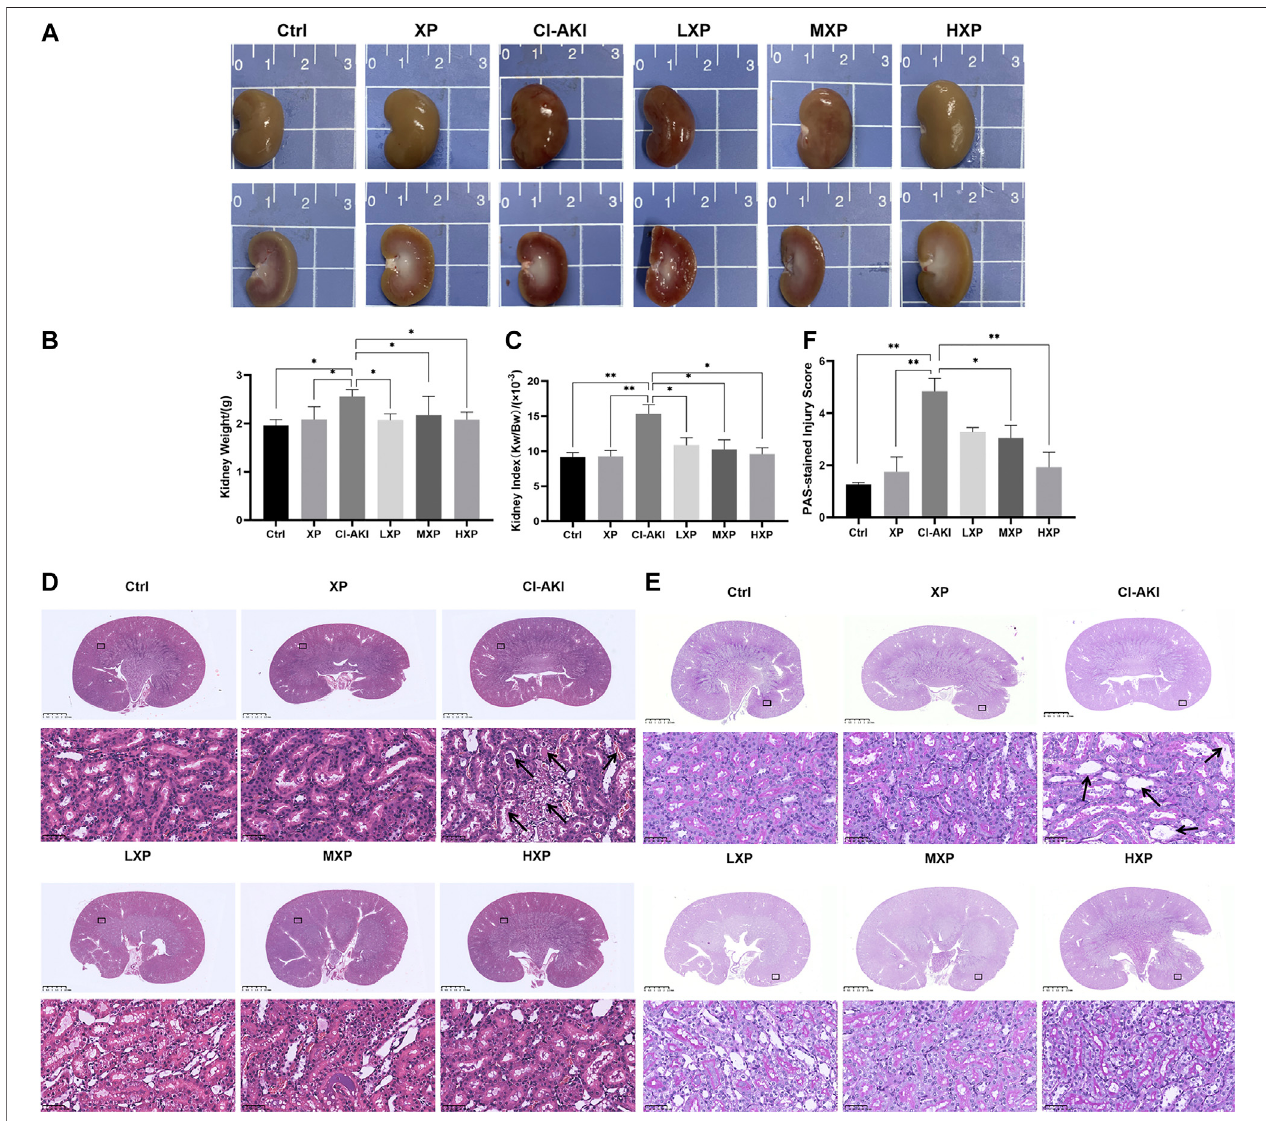
FIGURE 3 | XP attenuated morphological damage in contrast-induced kidney injury. (A) Kidneys in group CI-AKI had obvious congestion than kidneys of other groups. (BandC) ThekidneyweightandKIwereincreasedat24 hafteriohexolinjection( p < 0.05). (D) RepresentativephotomicrographsofHE-stainedkidneysections were presented (Magni fi cation: × 1 and × 400, scale bars: 2.5 mm (upper) and 50 μ m (lower)). (E) PAS-stained kidney sections (Magni fi cation: × 1 and × 400, scale bars: 2.5 mm (upper) and 50 μ m (lower)) and (F) semi-quantitative scoring analysis of tubular degeneration were presented. Marked plenty of tubular vacuolization and degeneration with shedding cells in the lumen, congestion in the vein, and obscure cell boundaries was shown in CI-AKI. For the semi-quantitative analysis of morphologicalchanges,theextentoftubularinjurywasgradedwithascorefrom0to4points.Datawerepresentedasmean ± SEM( n (cid:1) 6ineachgroup).* p < 0.05;** p < 0.01;*** p < 0.001basedonone-wayanalysisofvariance.Representativeimagesarepresented.HE,hematoxylinandeosin;PAS,PeriodicAcid-Schiff;KI,kidneyindex; Ctrl, control; CI-AKI, contrast induced-acute kidney injury; LXP, low dose XP combined with iohexol; MXP, medium dose XP combined with iohexol; HXP, high dose XP combined with